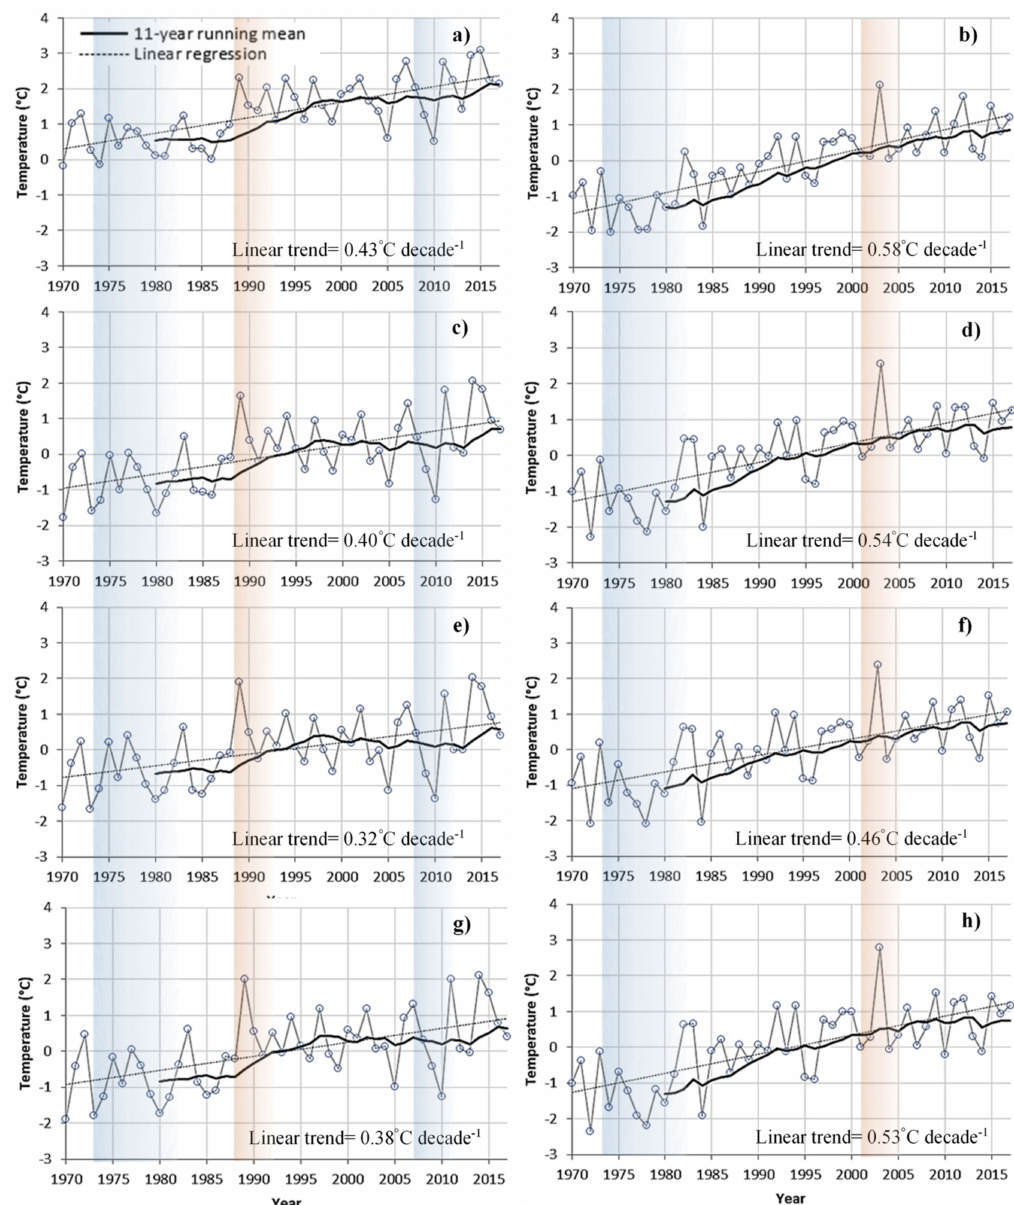
Figure 5. Winter air temperature anomalies are shown for ( a ) the southern Rhone (including Gietro, Hohlaub, Allalin, and Schwarzberg glaciers), ( c ) the northern Rhone (including Grosser Altesch, Gries, and Rhone glaciers), ( e ) Silvretta, ( g ) Clariden. Summer air temperature anomalies are presented in ( b ) the southern Rhone, ( d ) the northern Rhone, ( f ) Silvretta, ( h ) Clariden. The blue and red shades show significant